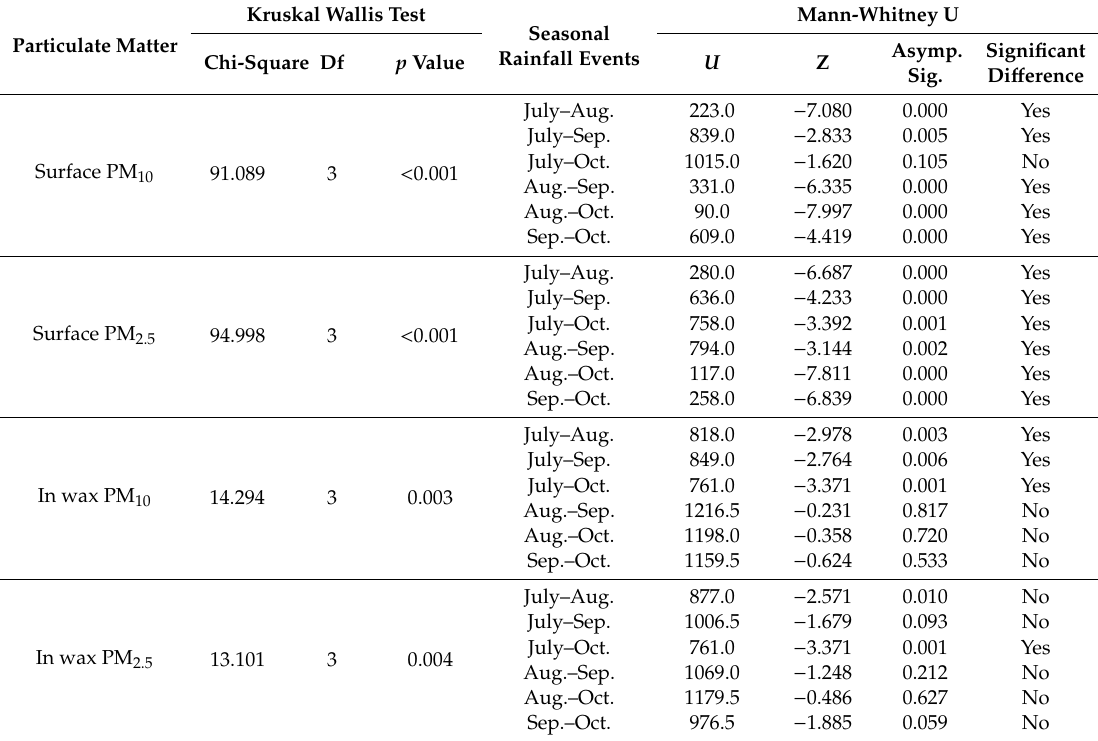
Table 2. Post hoc multiple comparisons with Bonferroni correction, using the Mann–Whitney U test of PM adsorption amount of leaves during the four rainfall